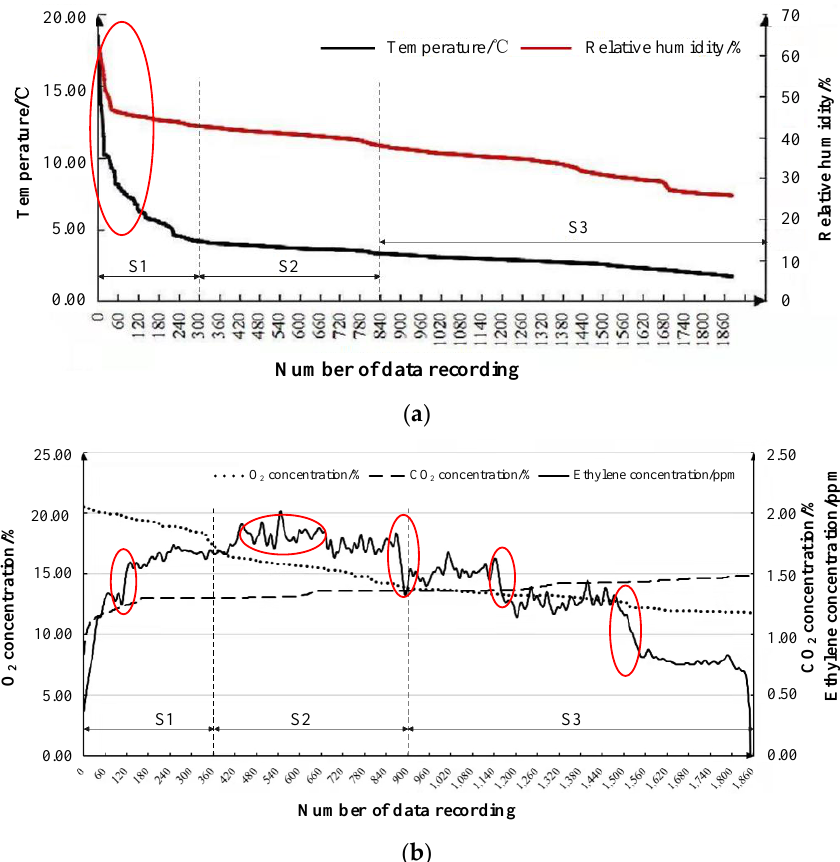
Figure 8. Matsutake micro-environmental parameter changes during at 2 – 5 °C: ( a ) scatter plot of temperature and relative humidity changes; ( b ) gas concentration changes.